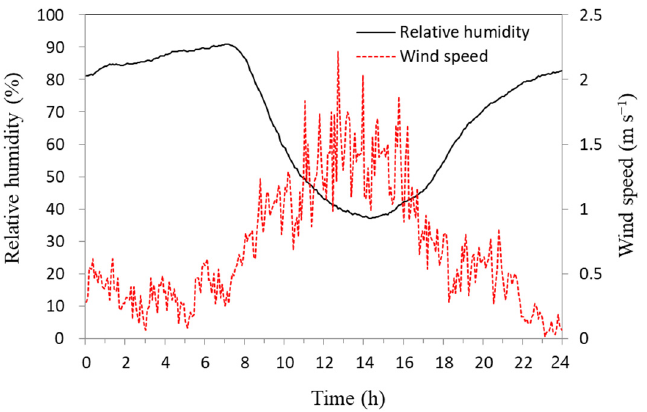
Figure 3. Variations in outside relative humidity and wind speed over time (12 − 13, 19 − 20, and 26 − 27 October 2019).